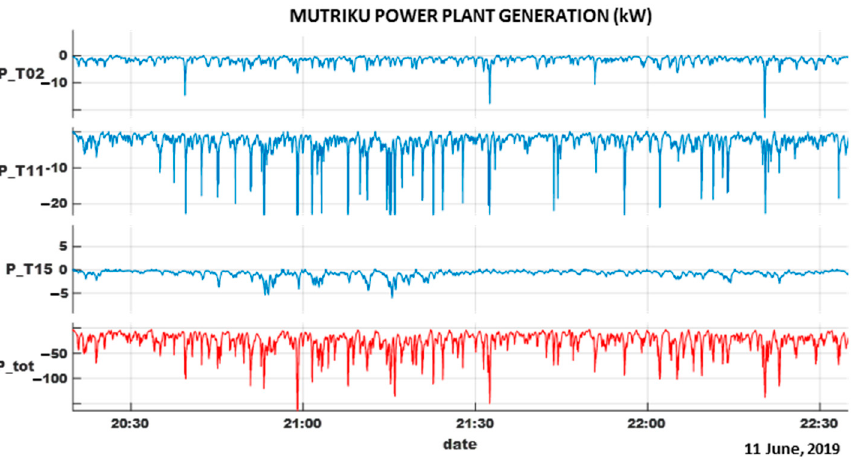
Figure 10. Power profile of three representative turbines of the wave power generation plant and total power in a stretch of time of the period studied.